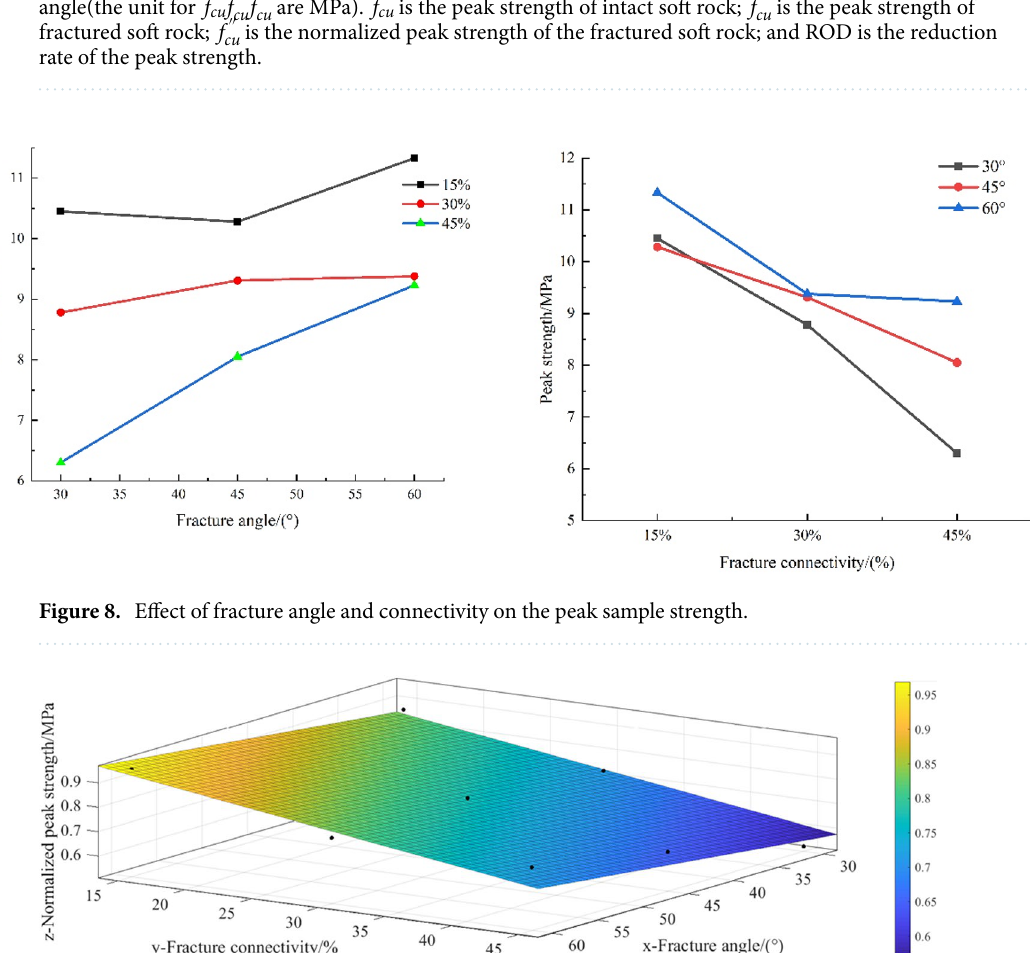
cu is the peak strength of